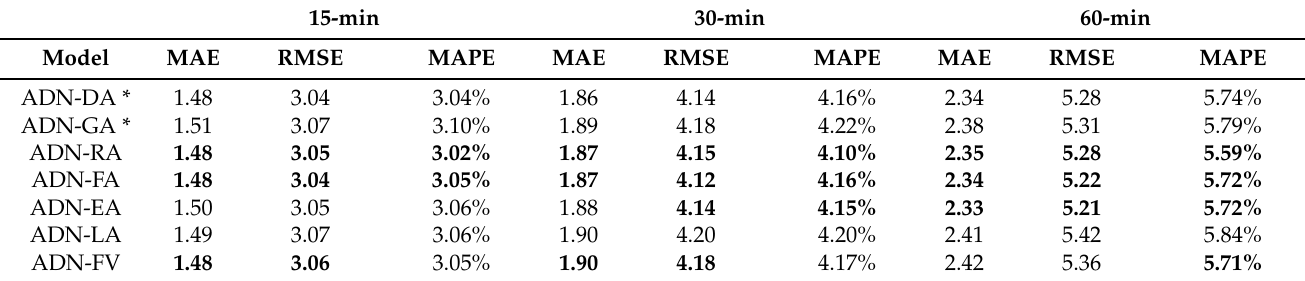
Table 5. Errors of models based on ADN with different attention mechanisms, on PeMS-Bay. Models marked with * represent our own implementation of the